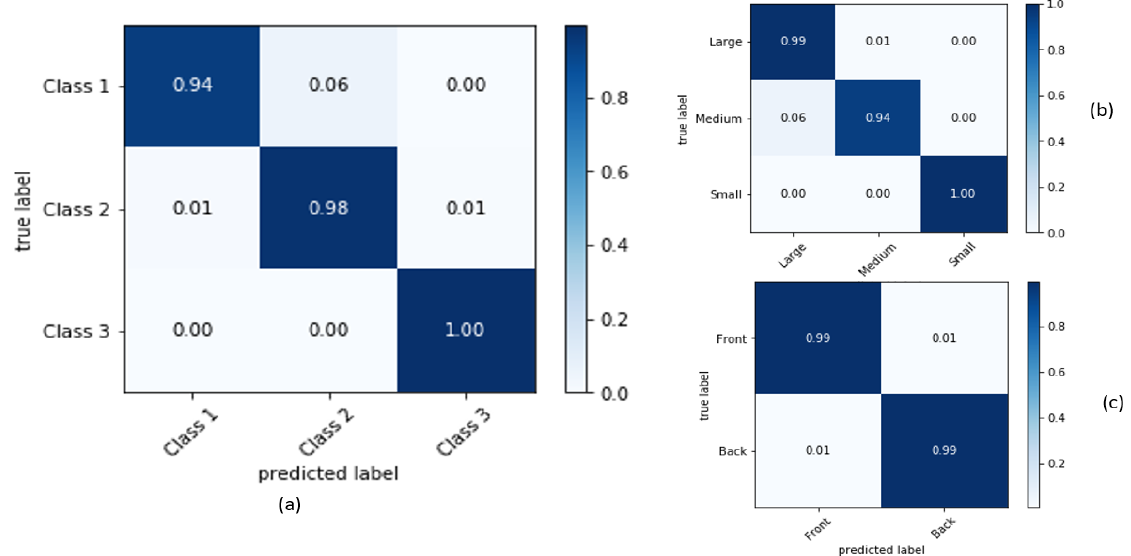
Figure 9. Normalized Confusion Matrix for ( a ) class prediction, ( b ) size prediction, and ( c ) view prediction.